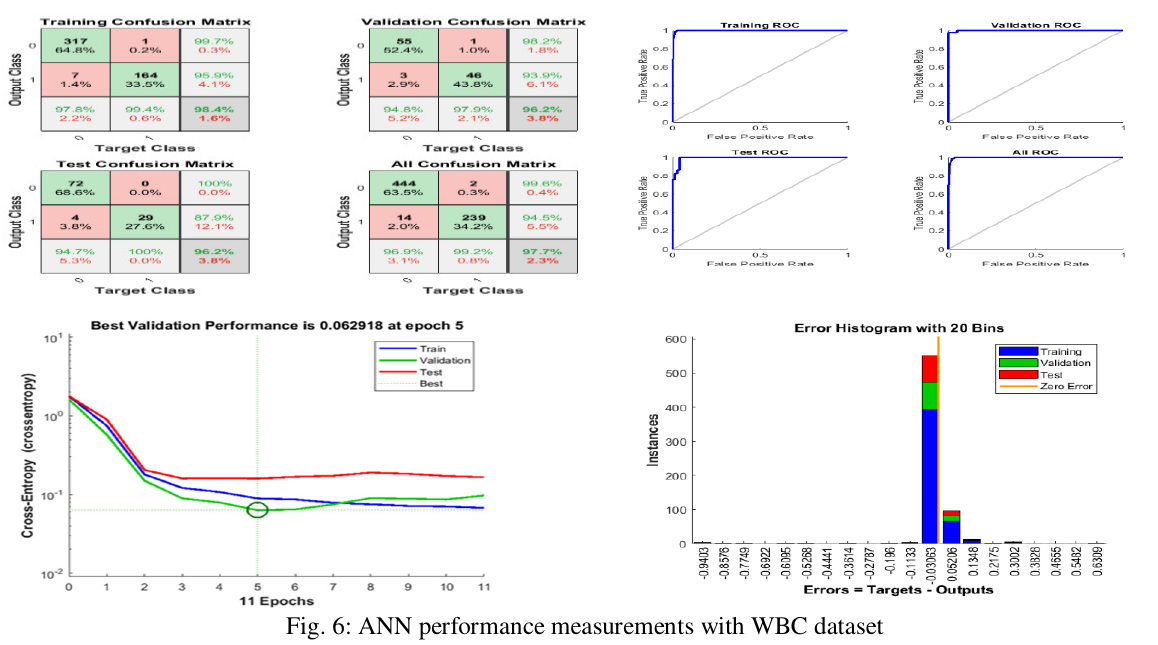
Fig. 6: ANN performance measurements with WBC